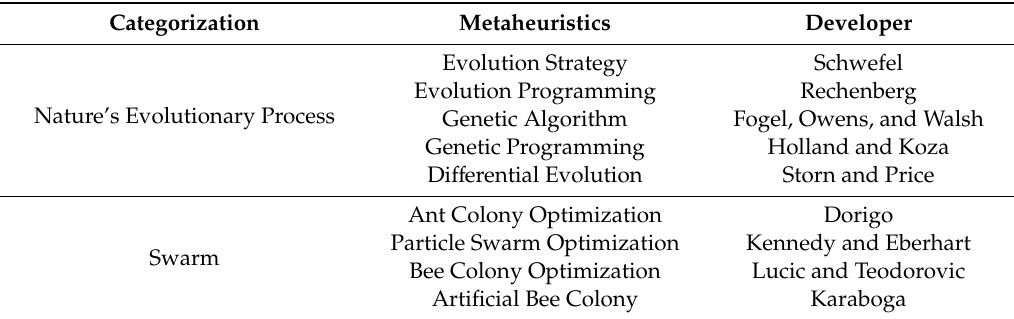
Table 1. Classification of Metaheuristics